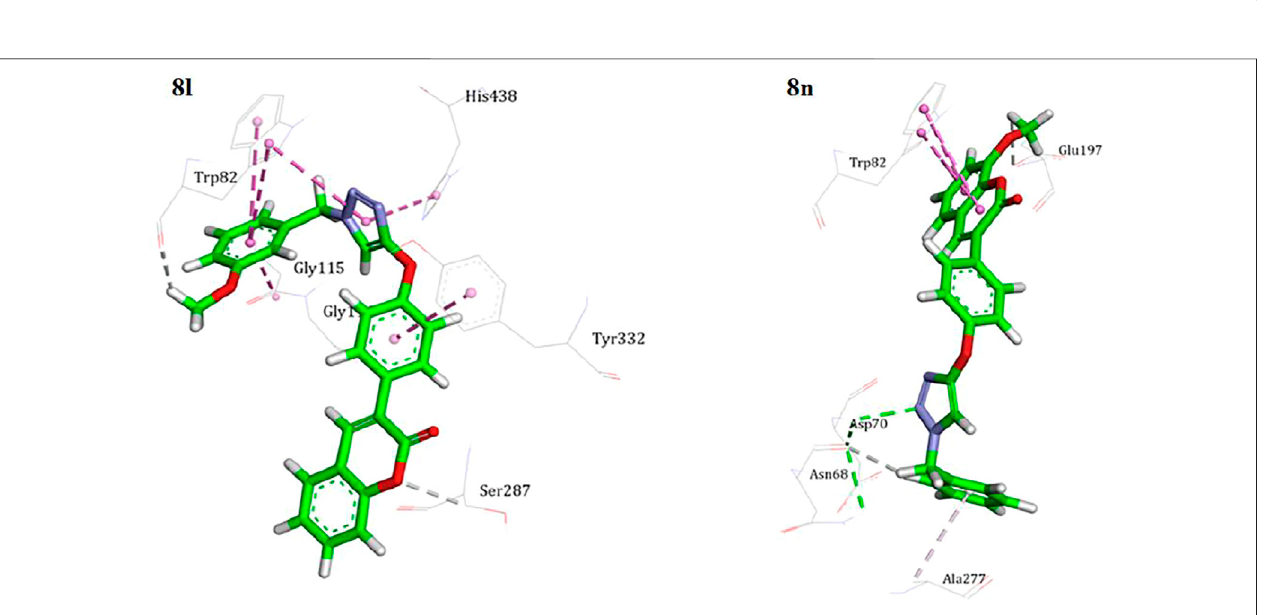
Frontiers in Chemistry |